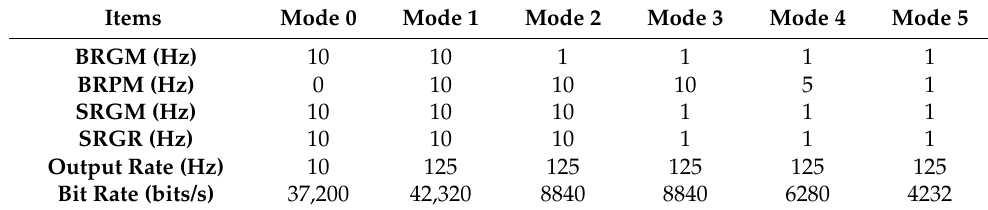
Table 2. Modes of sampling and broadcast rate in test 1.